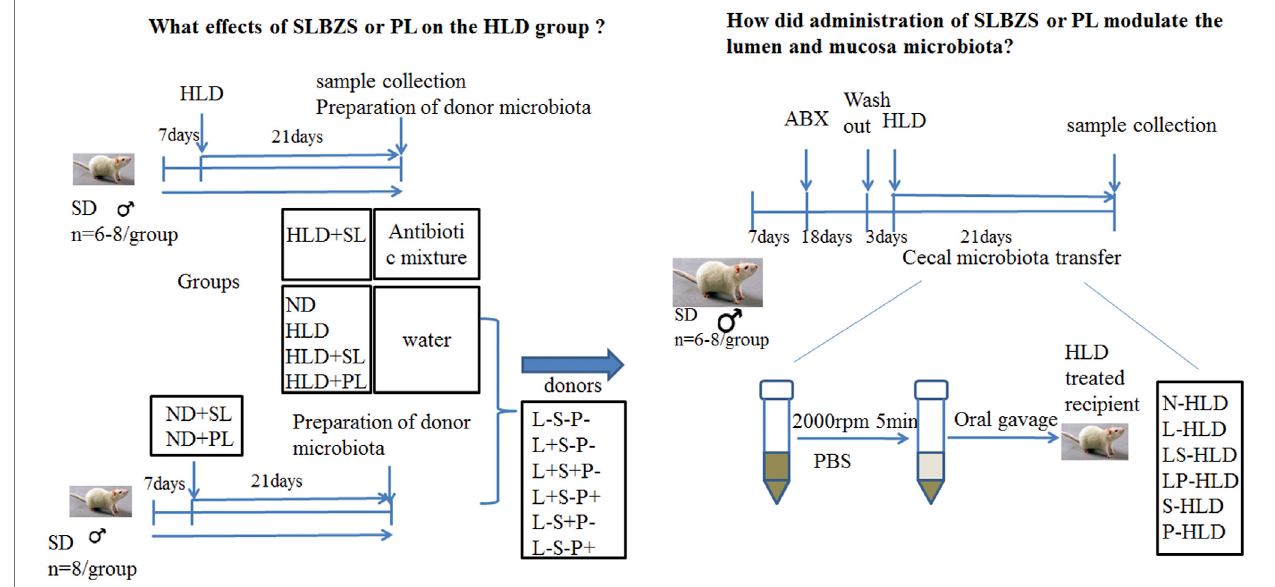
FIGURE 1 | Schematic of the experimental